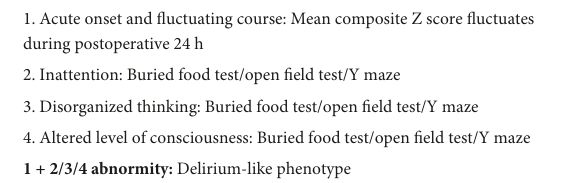
TABLE 1 The tool to assess postoperative delirium for